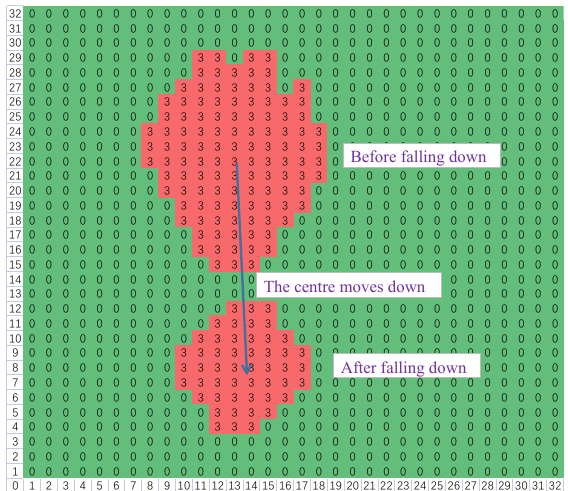
Figure 13. The locked body area moves down, and the number of locked points decreases after falling down.